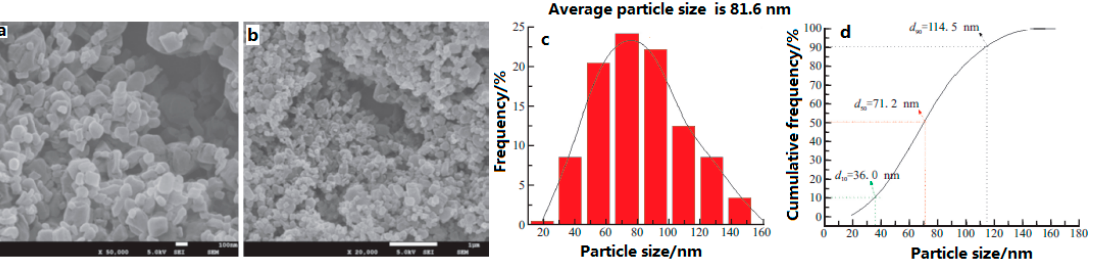
Figure 11. SEM photographs and particle size distribution of nano-sized CL-20 / HMX cocrystal. ( a ) 50,000; ( b ) 20,000; ( c ) Frequency distribution; ( d ) Cumulative frequency distribution [9], with permission from Gu Ti Huo Jian Ji Shu, 2018.